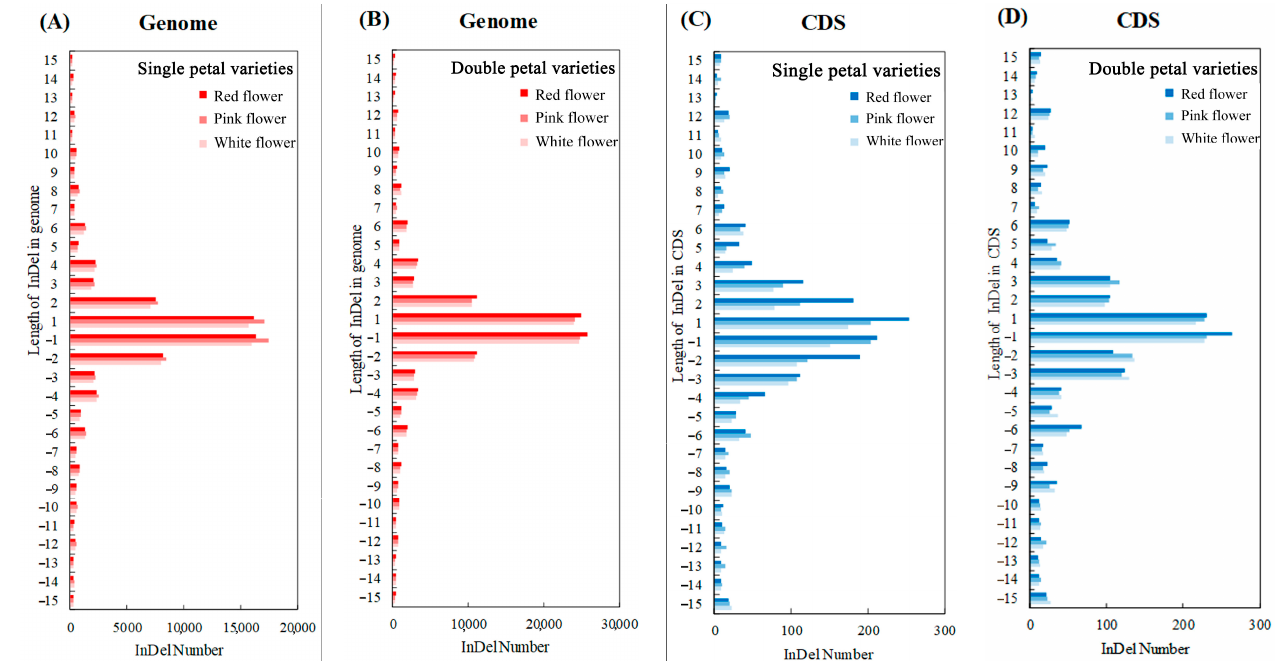
Figure 6. Length distribution statistics of insertion or deletion. ( A ) Length distribution map of insertion or deletion in genome region of single-petal varieties; ( B ) Length distribution map of insertion or deletion in genome region of double-petal varieties; ( C ) Length distribution map of insertion or deletion in CDS region of single-petal varieties; ( D ) Length distribution map of insertion or deletion in CDS region of double-petal varieties.